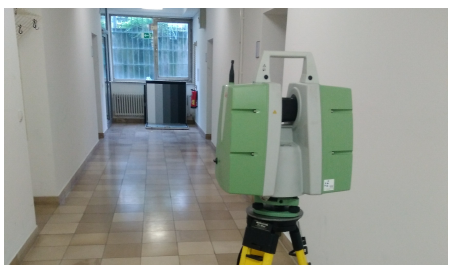
Figure 4. Experimental setup to examine reproducibility of intensity